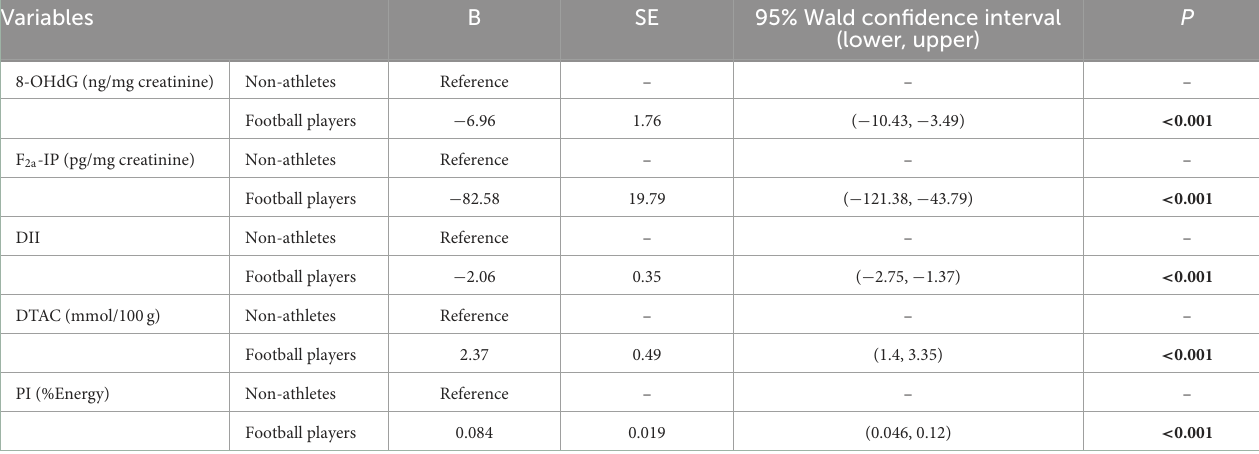
TABLE 3 GEE results for comparing oxidative biomarkers and dietary indices between football player and non-athlete groups. Variables B